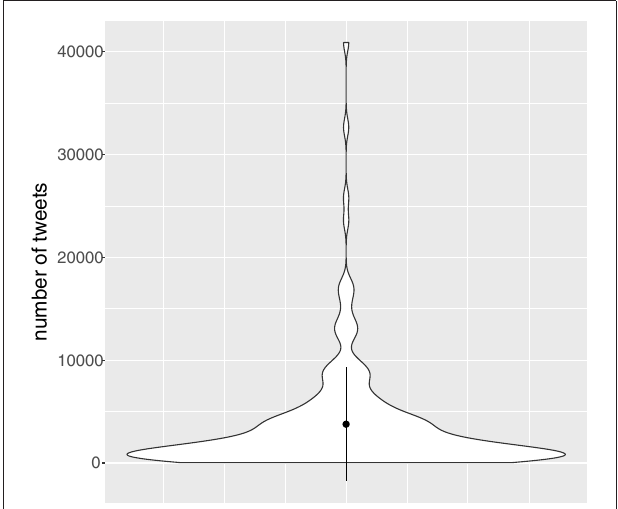
FIGURE 2 | Violin plot showing the distribution of the number of tweets per Twitterer in the period from January 1, 2010 until December 31, 2019 ( n = 698,369, N = 186). The black dot represents the mean, and the vertical line represents 1 standard deviation on either side of the dot.